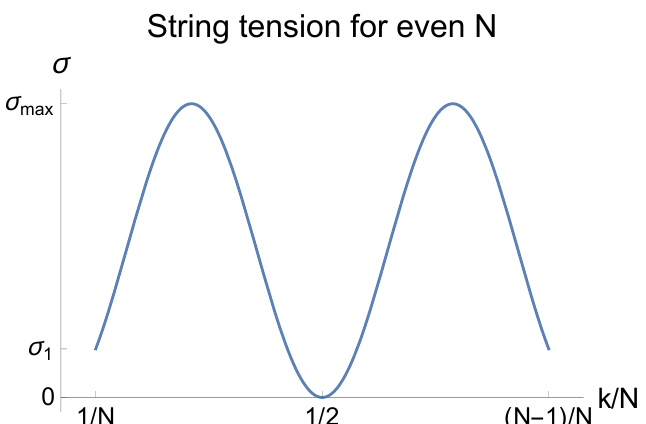
Figure 2: A sketch of the string tension in 2d SU ( N ) adjoint QCD for even N as a function of N -ality k . We draw a smooth curve, but of course for finite N the spectrum of string tensions is discrete. The string tension must vanish at k = N / 2 to satisfy ’t Hooft anomaly matching. The sketch also shows the (generically) four-fold degeneracy of the string tension predicted by our discussion. Note that this double bump structure is required only for even N . It is not required for odd N